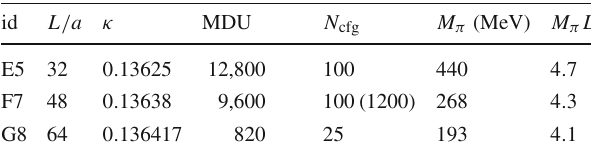
Table1 Overviewoftheensemblesandstatisticsusedinthisstudy.We give the label, the spatial extent of the lattice, the hopping parameter κ , the number of MDUs simulated after thermalization, the number of independent configurations selected N cfg , the pion mass M π , and the product M π L . For F7, N cfg = 100 configurations have been used for estimating the variances while the final results for the two-point functions have been obtained with N cfg =